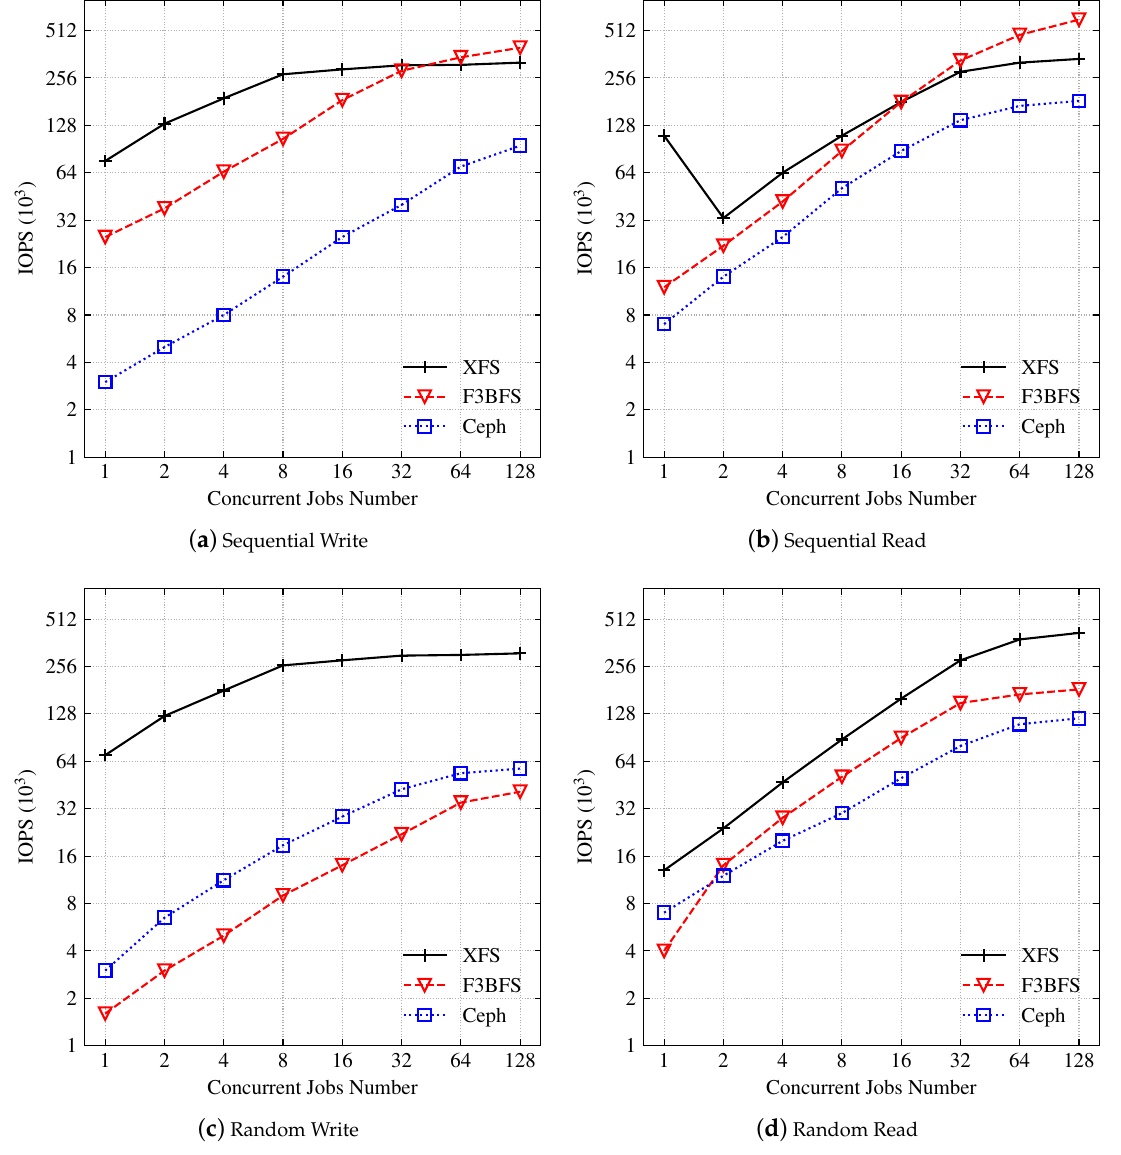
Figure 4. IOPS evaluation for sequential and random IO operations,